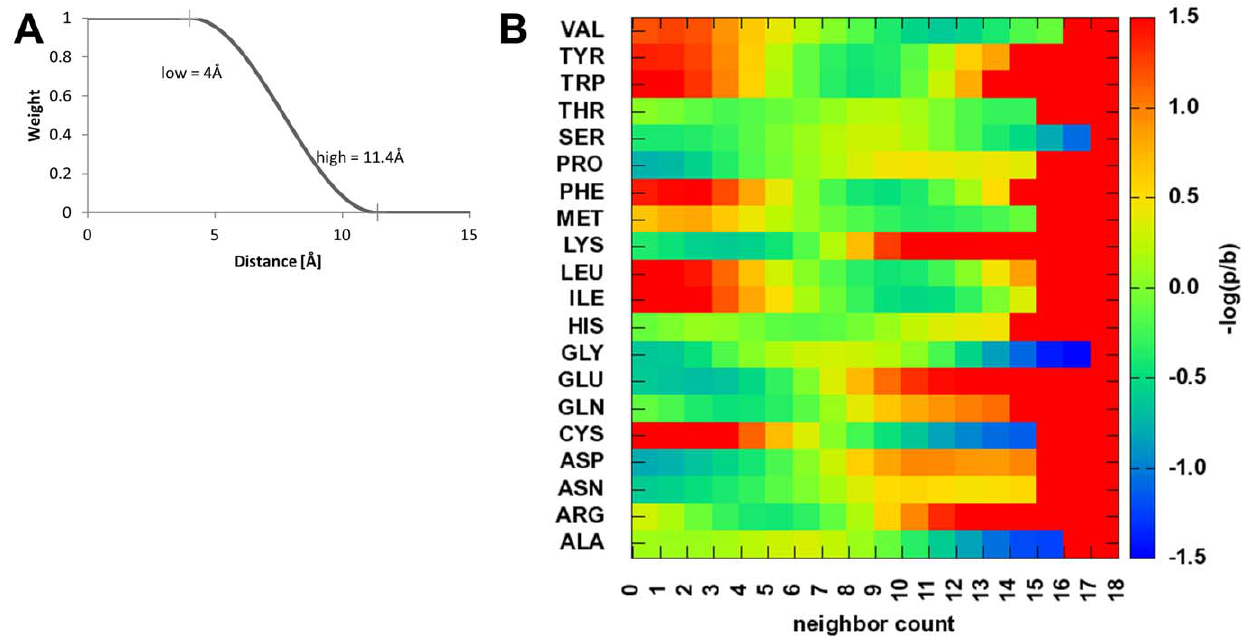
Figure 1. Amino acid neighbor count environment potential. A shows the transition function that is used between the lower and upper threshold in which the weight for the neighbor being considered drops from 1 (4 A˚) to 0 (11.4 A˚) using half of a cosine function. B shows the neighbor count energy potential for all 20 amino acids with their three letter code.